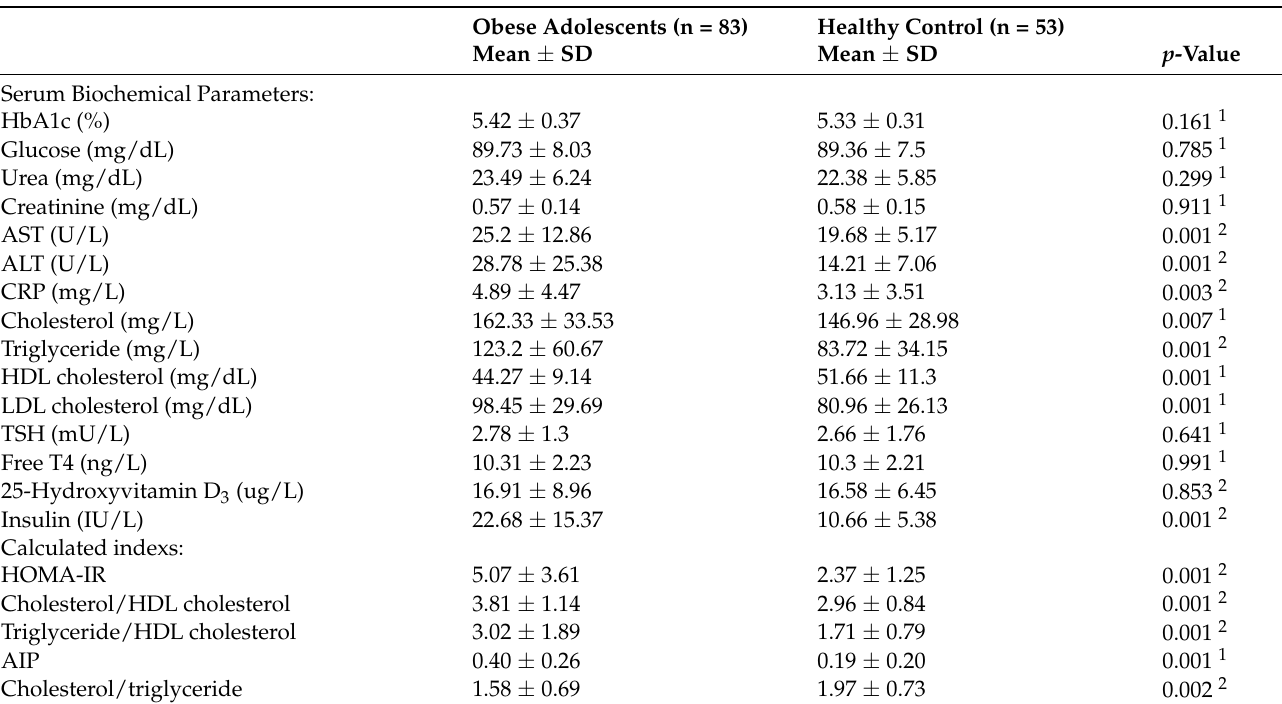
Table 1. Data on obese adolescents and healthy